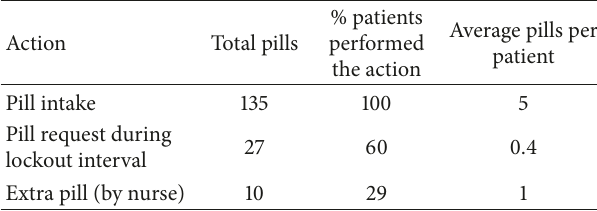
Table 2: Summary of actions performed by patients in the test group, to obtain pain medication by PCoA Acute. Data was obtained from PCoA Acute log